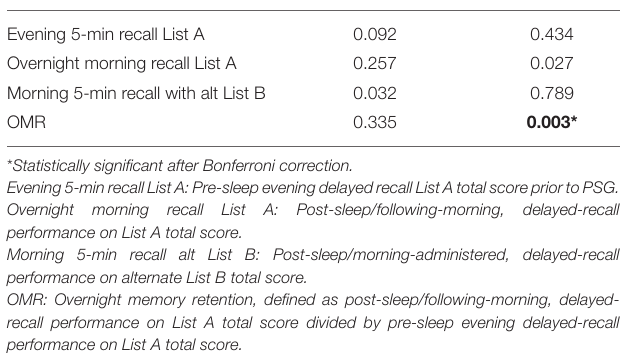
TABLE 4 | Partial correlation analysis to examine the association of slow oscillation (0.5–1Hz) during the first 88.5min of sleep and list-learning scores covaried for age, gender, and year of education among 90 participants without SWS and correlation coefficient. 77 participants without SWS, partial correlation with relative power spectrum of slow oscillaition during the first 88.5min (177 epochs), covaried for age, gender, years of